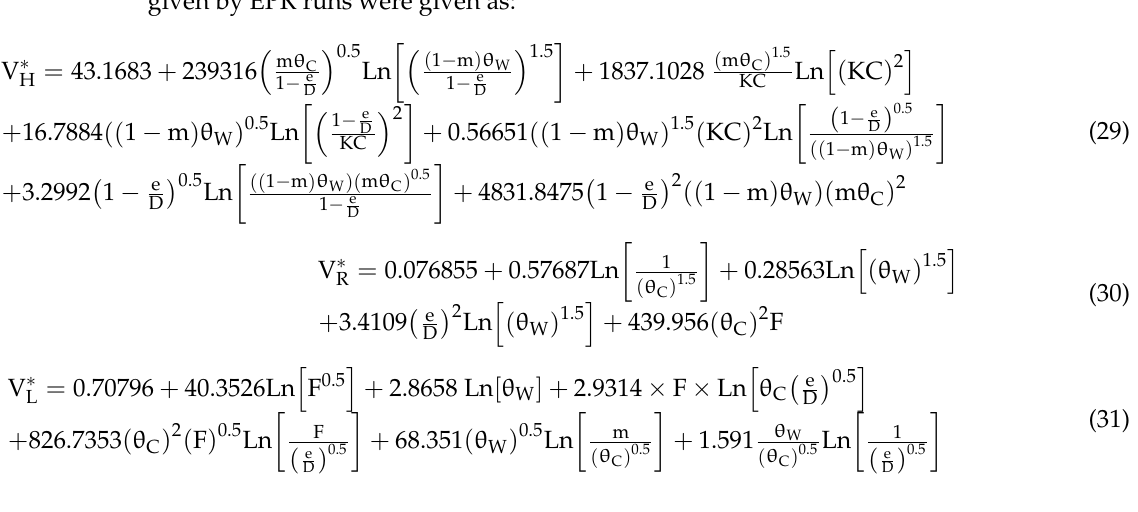
Table 11. Correlations of EPR performance in the calibration and validation stages for 3D scour rates. V H * V R * V L Set No.